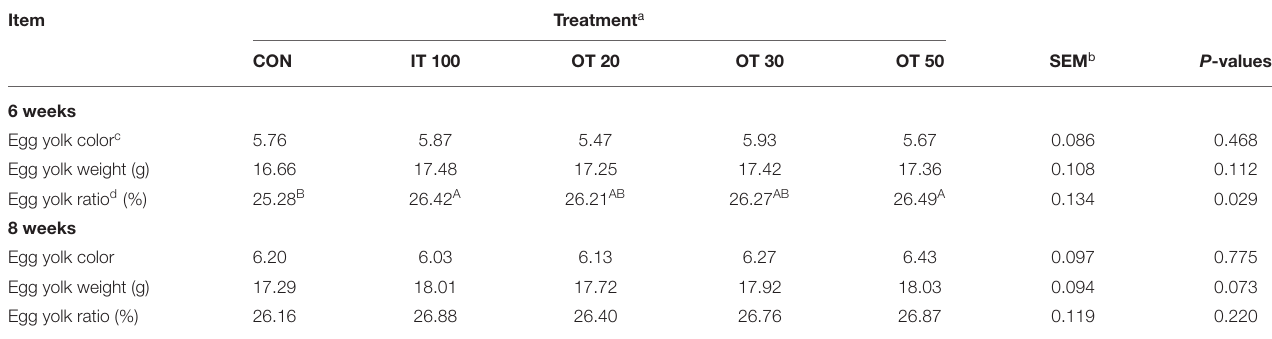
TABLE 3 | Effects reduced substitution of organic trace minerals on deposition of Fe, Cu, Mn, and Zn of liver, egg yolk at 8th week of experimental period with hen layer at the age of 67 weeks ( µ g/g, dry matter basis). Item